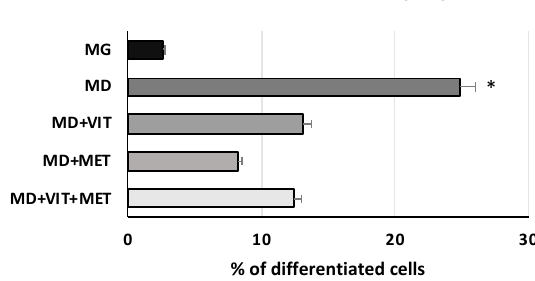
Figure 1. Optical microscope analysis of ADSC morphology during differentiation: ( A ) Figure shows morphological changes in cells treated with adipogenic differentiation medium (MD), or in MD plus vitamin D (MD+VIT), or in MD plus metformin (MD+MET), or in MD with both metformin and vitamin D (MD+VIT+MET), as compared to control untreated cells (Ctrl). ADSCs cultured in adipogenic medium alone acquired the appearance of mature adipocytes (MD). Scale bar = 100 µ m. ( B ) The number of mature adipocytes was calculated using ImageJ. Data are expressed as mean ± SD referred to the control (* p ≤ 0.05).